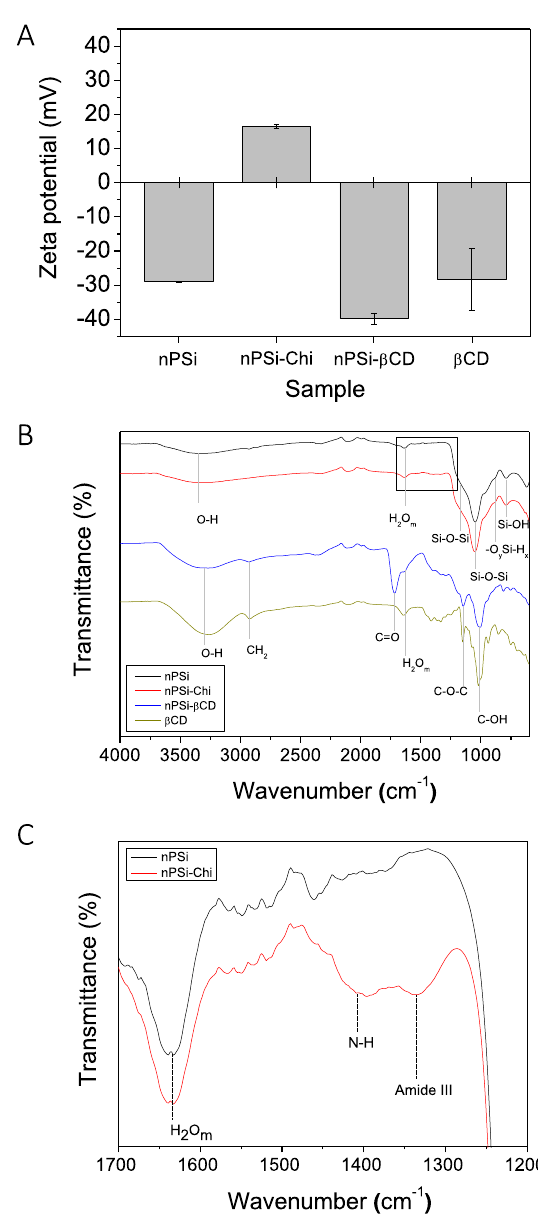
Figure 2. Monitoring of the synthesis process of nPSi-βCD composite microparticles via: ( A ) Zeta potential and ( B ) Attenuated total reflectance Fourier transform infrared spectroscopy analysis (ATR-FTIR) ( C ) Zoom in of ATR-FTIR spectra.